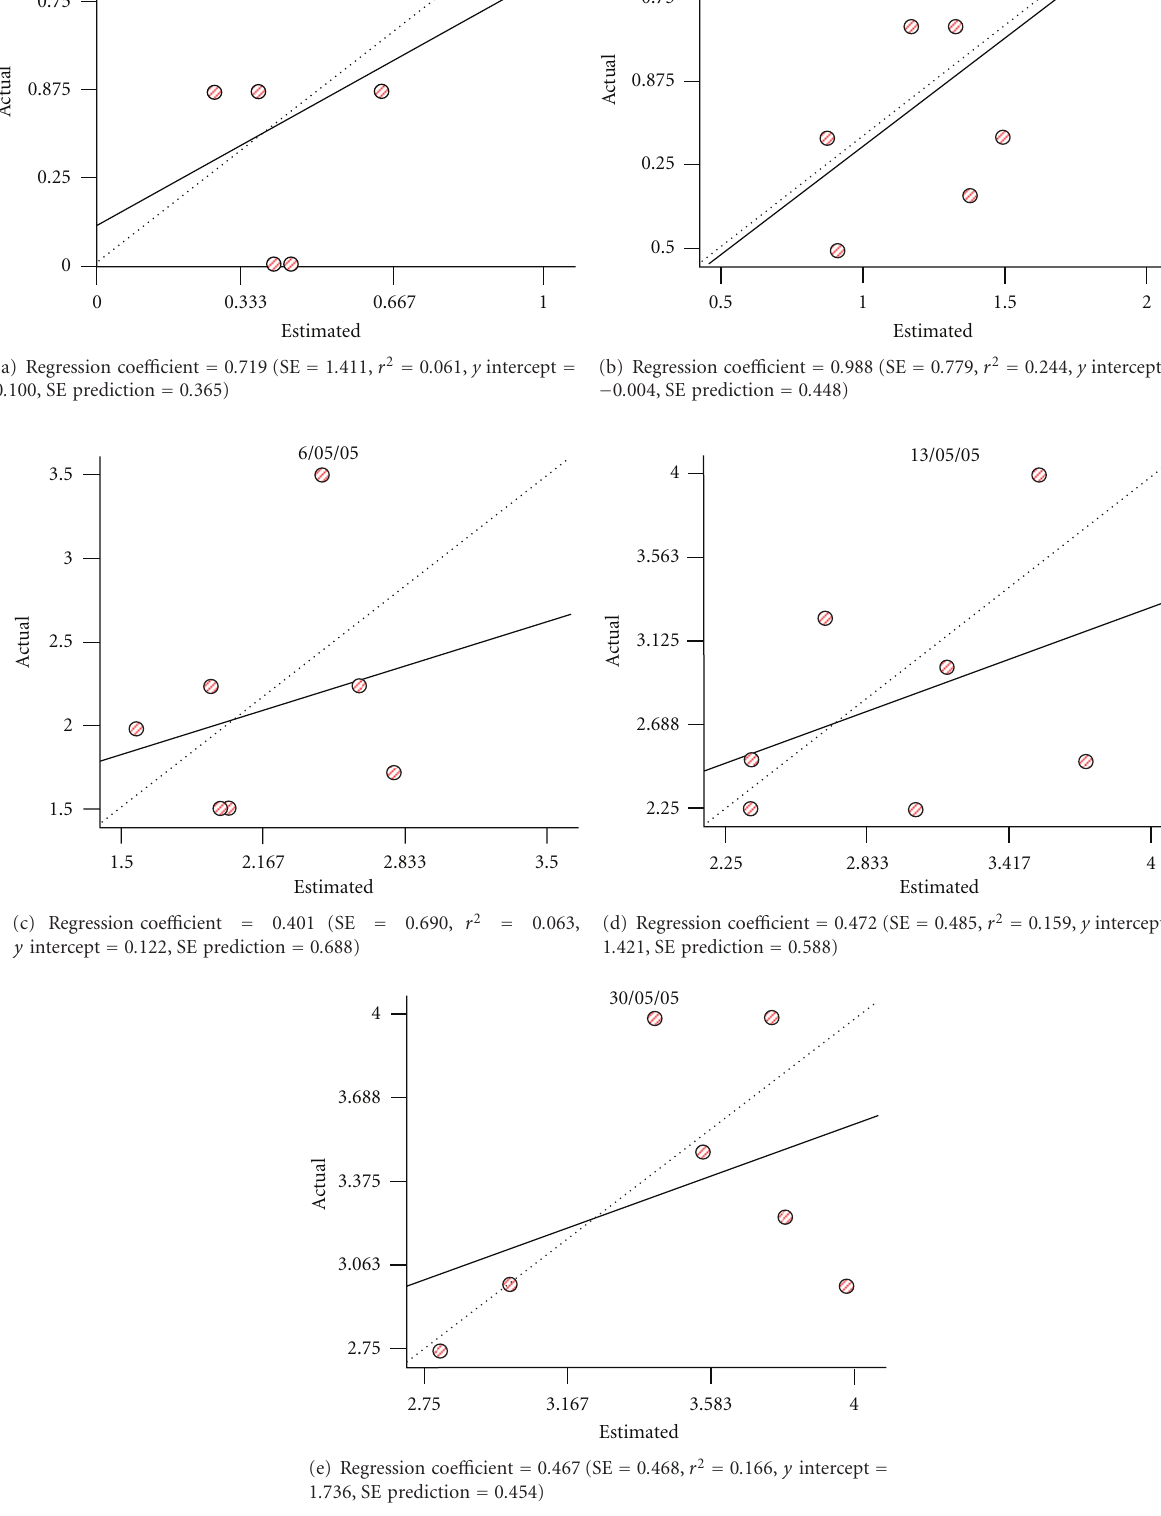
Figure 4: Cross-validation analyses (variograms) obtained for year